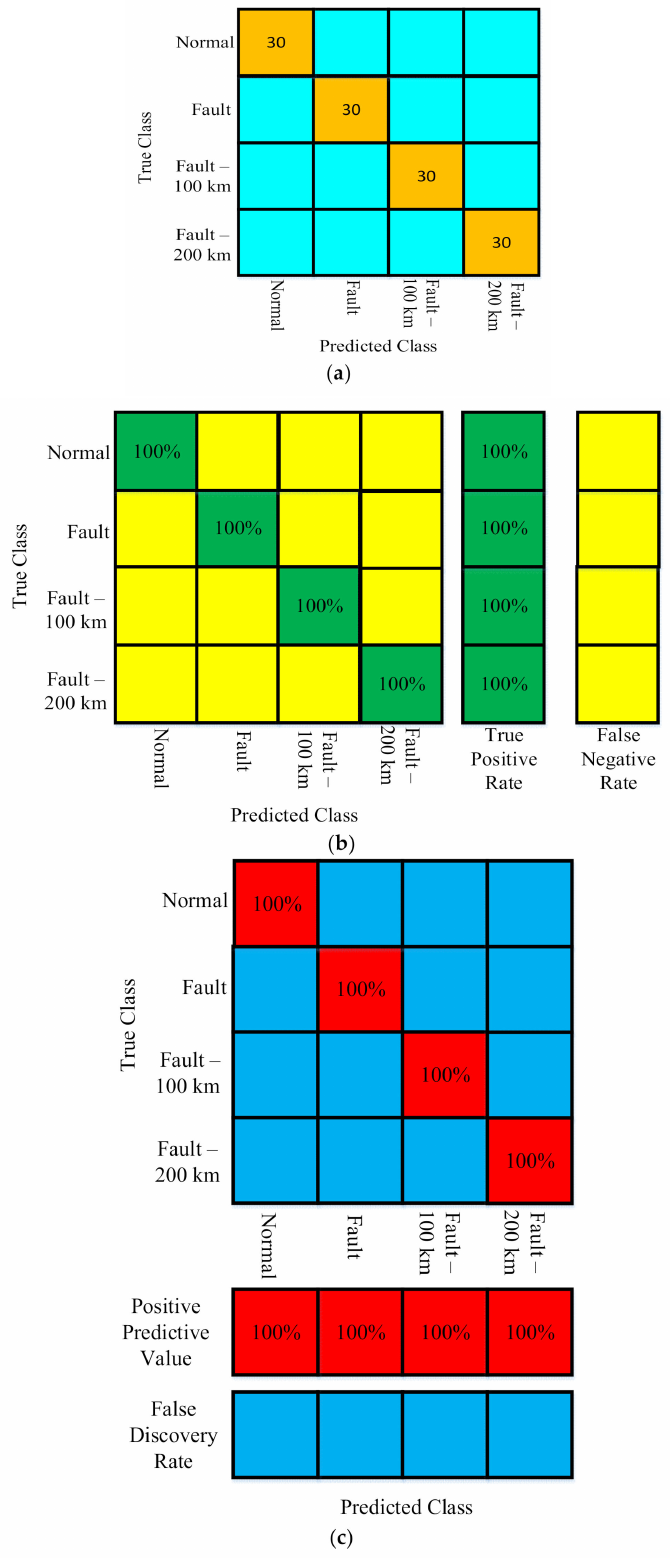
Figure 33. Confusion matrices based performance evaluation of the proposed technique for fault identification, classification, and location in MT-HVDC